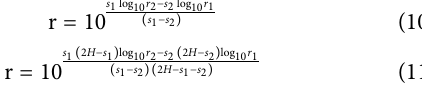
Frontiers in Environmental Science |